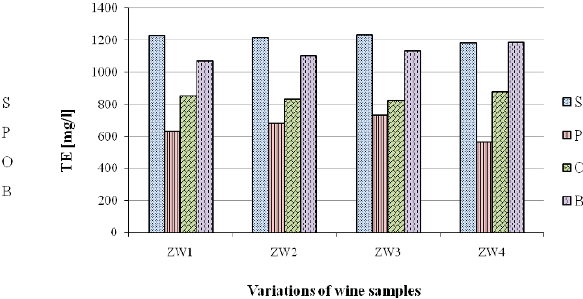
Figure 3. Total phenolic contents in 16 red wines from individual experimental vineyards in Czech Republic (S, P) and Austria (O, B). SDs values see Table 2 .